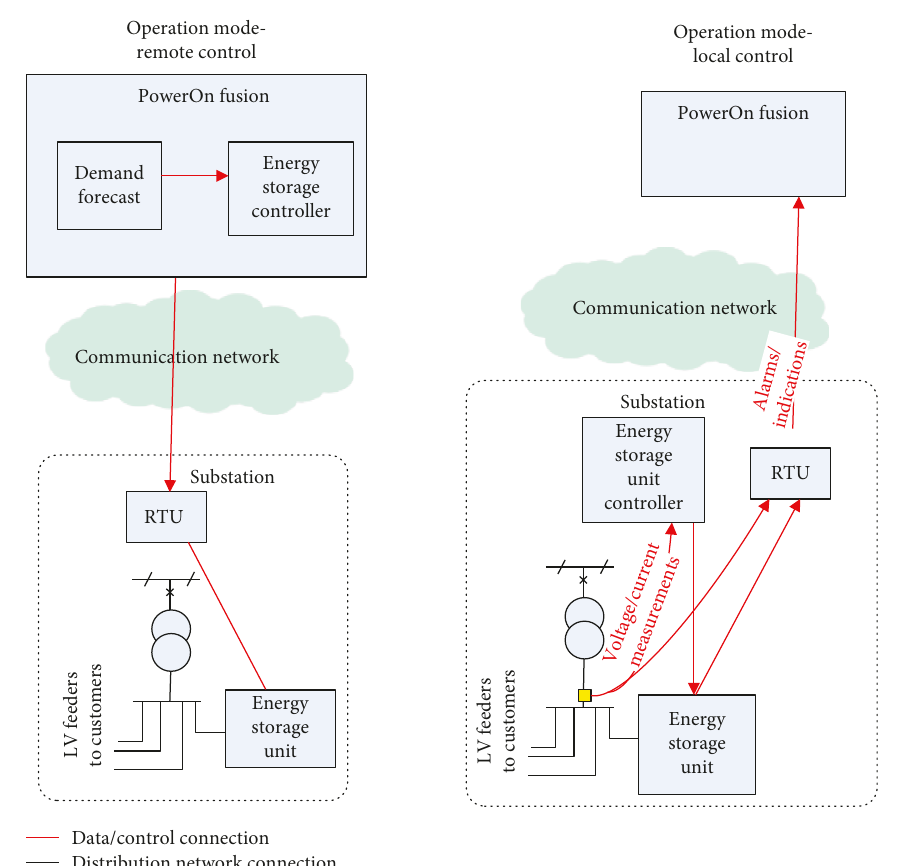
Figure 3: Storage trial